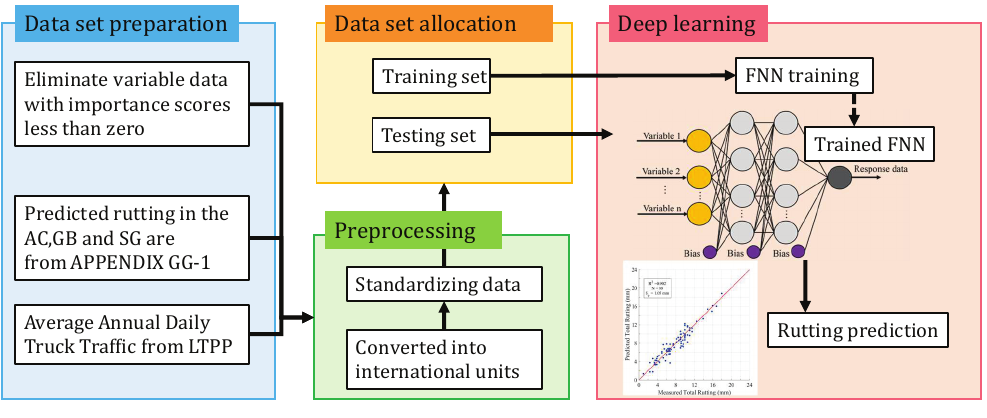
Data set preparation Data set allocation Deep